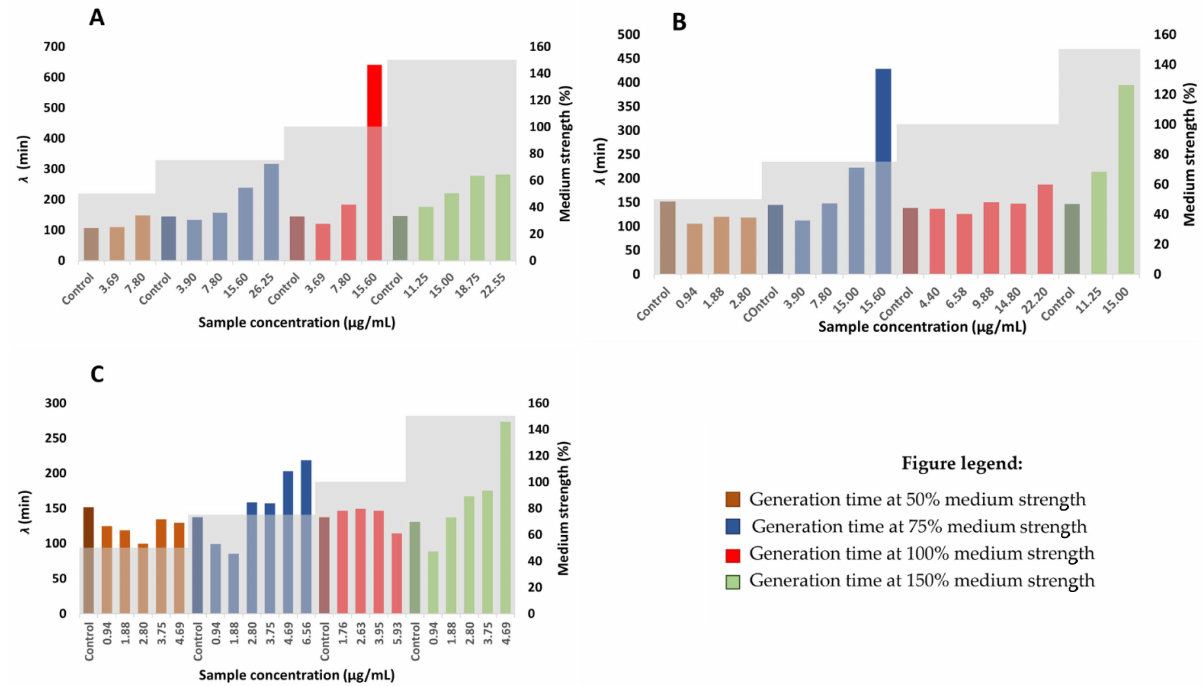
Figure 4. The effect of different concentrations of hop extracts on the generation time of Staphylococcus aureus ; ( A ) HAE Styrian Eagle, ( B ) αβ -AF extract, ( C ) β -AF